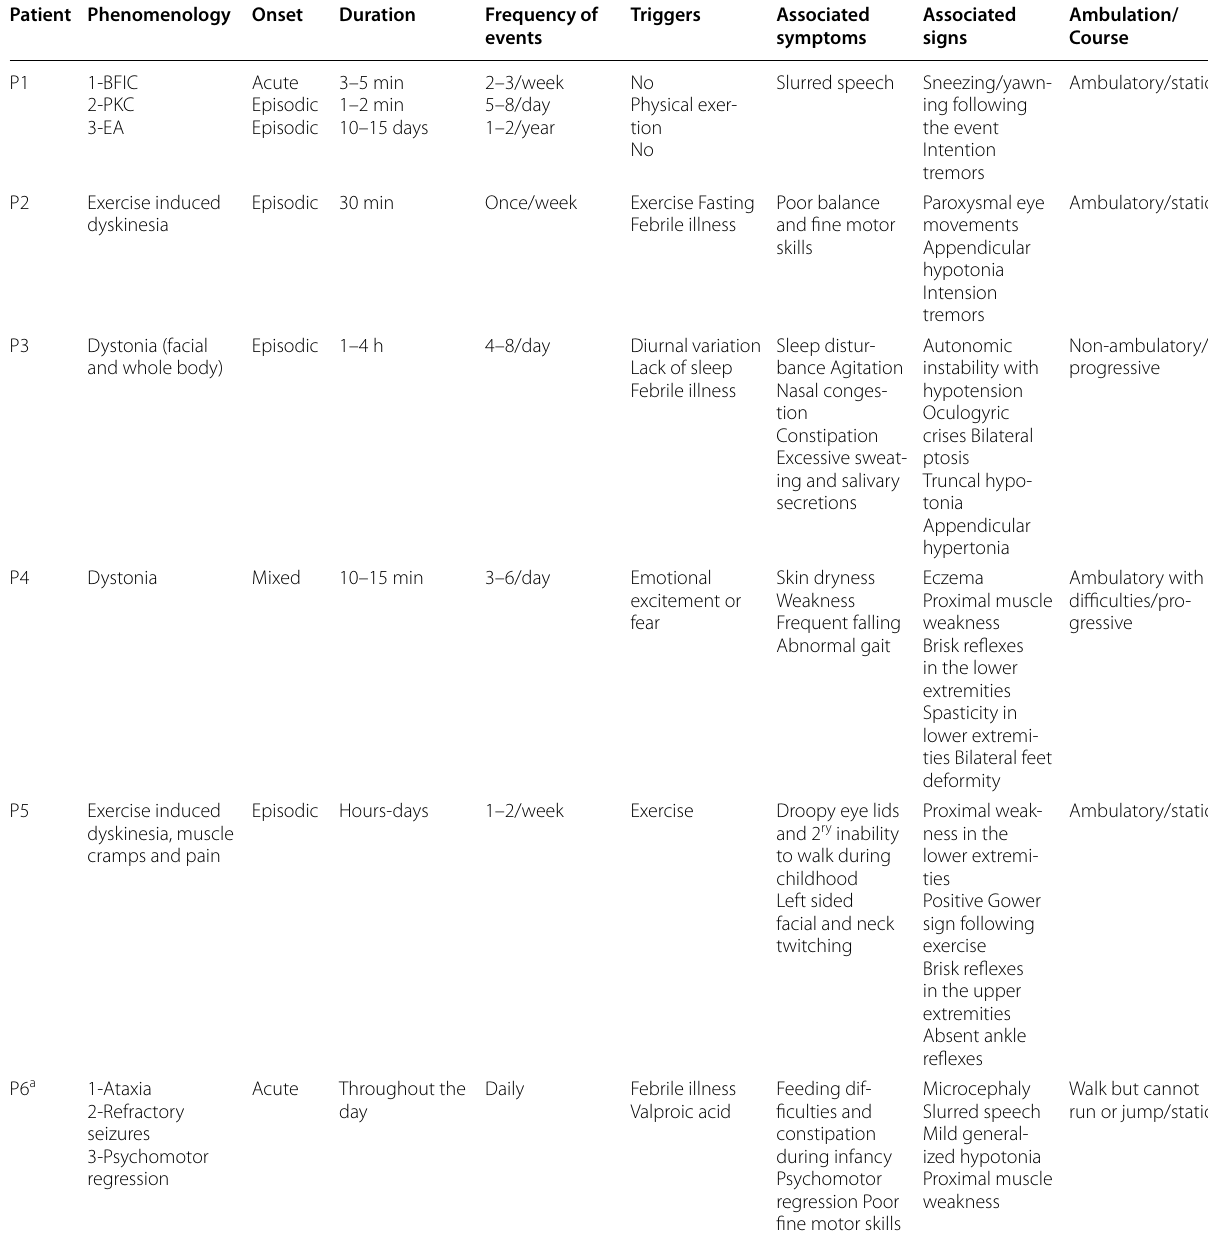
Table 2 Patient’s phenomenology, clinical features and